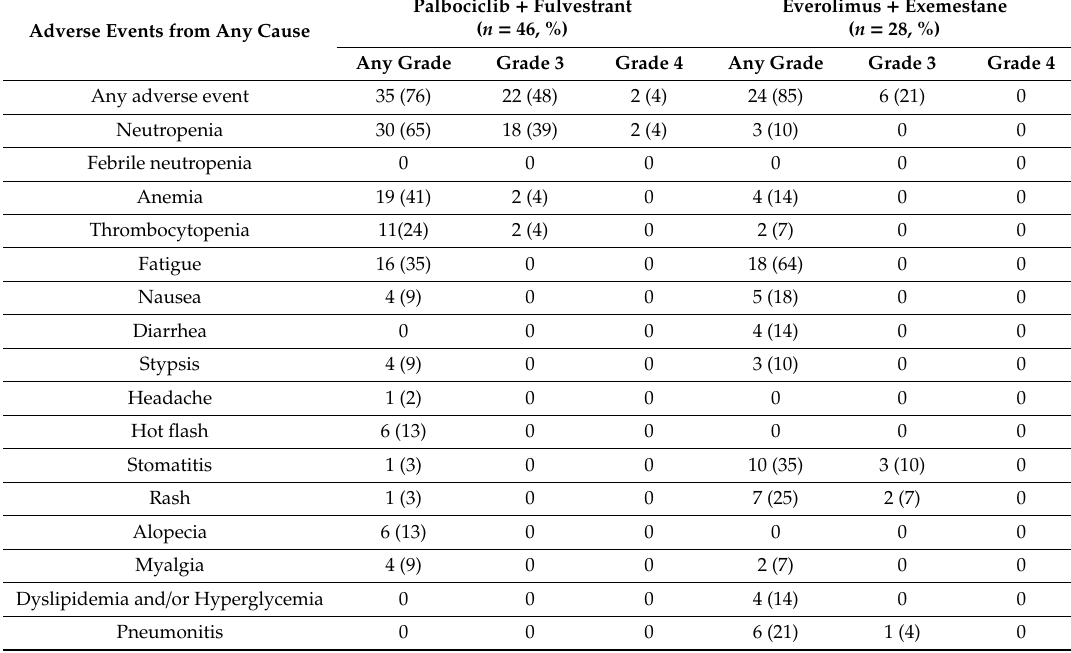
Table 3. Adverse events for any causes observed during the study